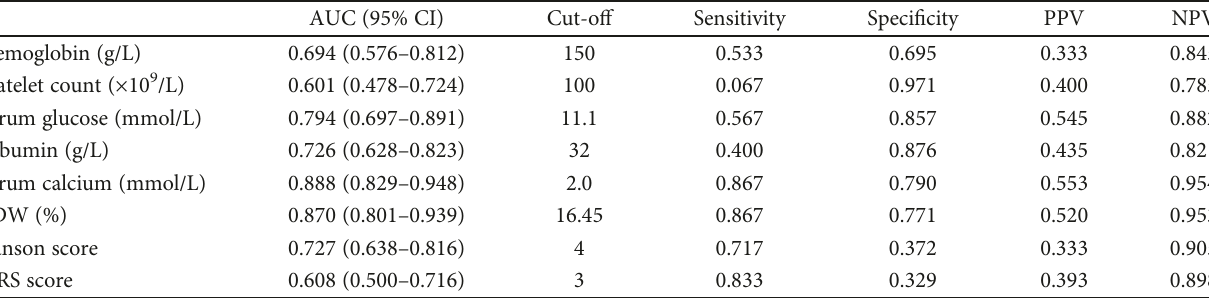
Table 6: Receiving operator curve analysis in diagnosing POF.